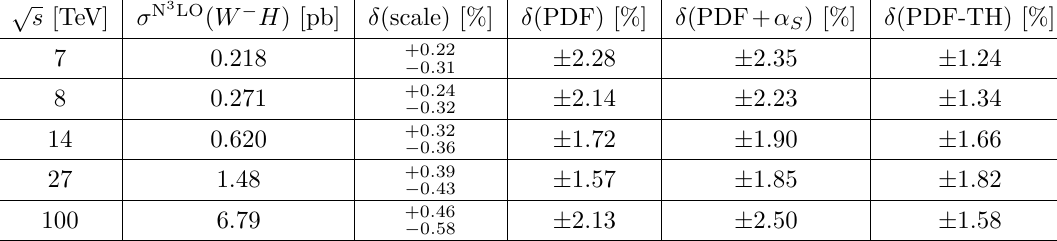
Table 8 . The same as in table 7, but for the W − H process.